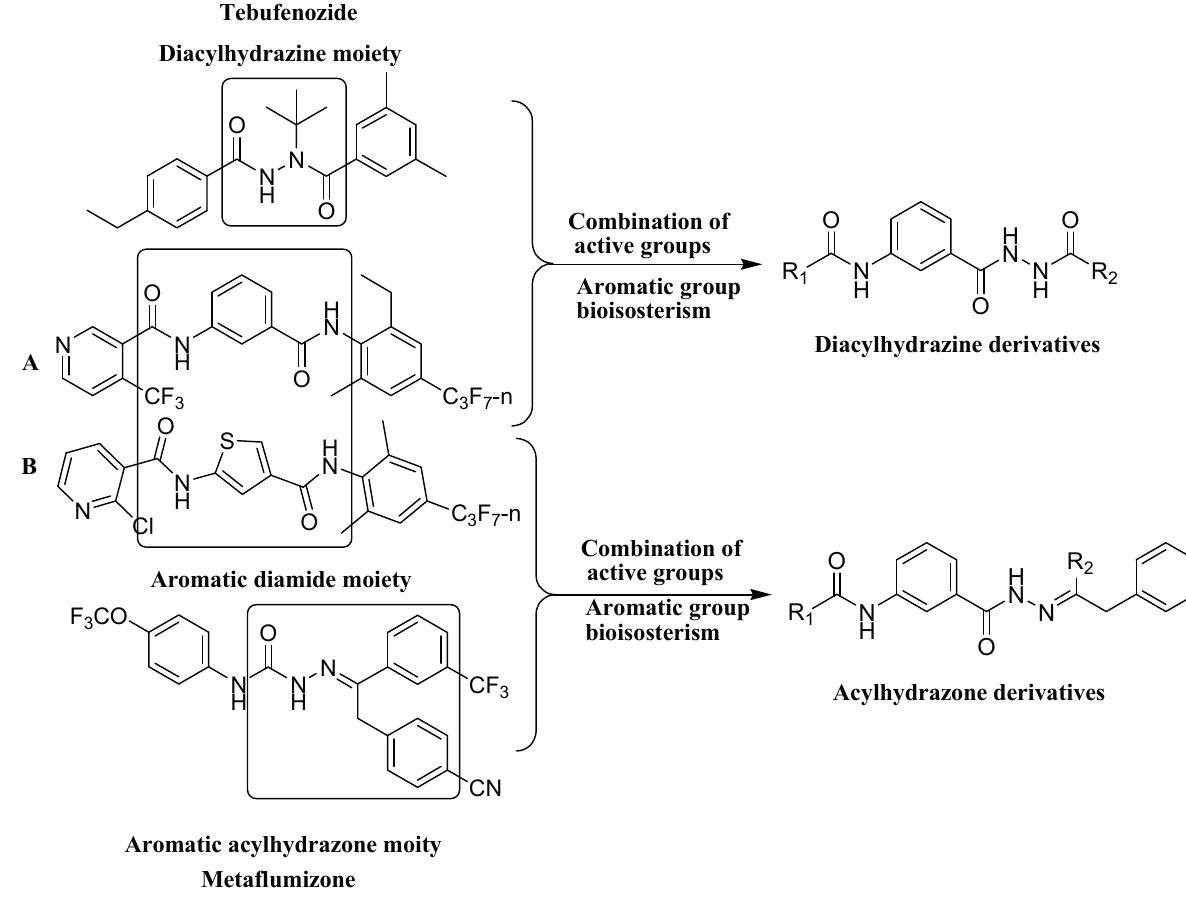
Figure 1. Design of the skeleton of diacylhydrazine and acylhydrazone